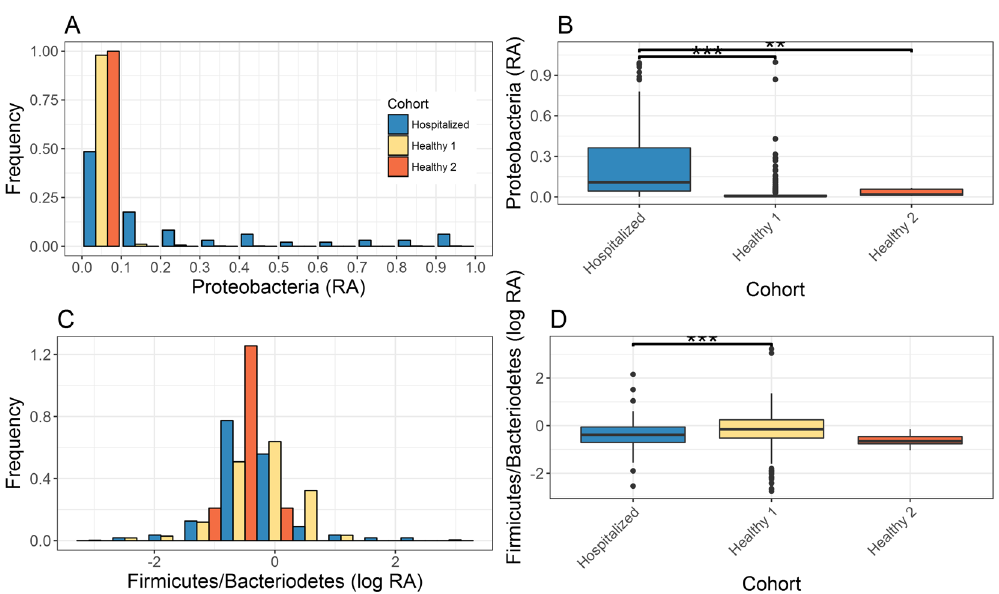
Figure 3. High abundance of Proteobacteria phylum in hospitalized patients. Changes are shown for Proteobacteria ( A , B ), and Firmicutes/Bacteroidetes ratio ( C , D ). Phylum level taxonomic relative abundance (RA) or log10 of RA ratio histogram ( A , C ) and boxplot ( B , D ) as indicated. Asterisks indicate significant differences (Bonferroni corrected Mann Whitney test: *** q < 0.001, ** q <